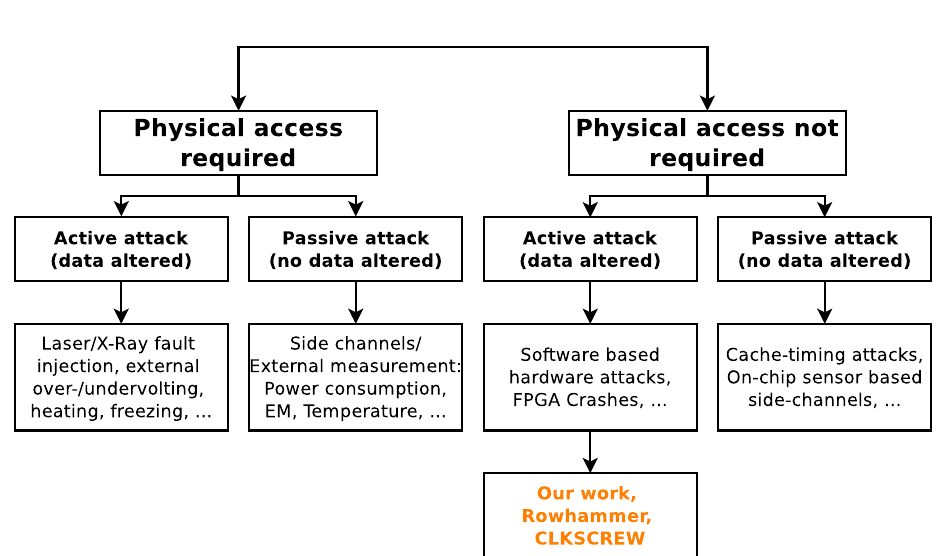
Figure 2: Proposed classification of different hardware attacks with our work